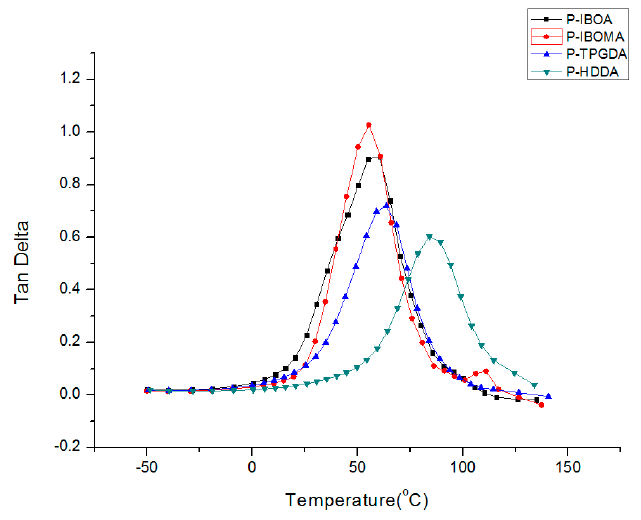
Figure 6. DMA properties of UV-cured PUA coating